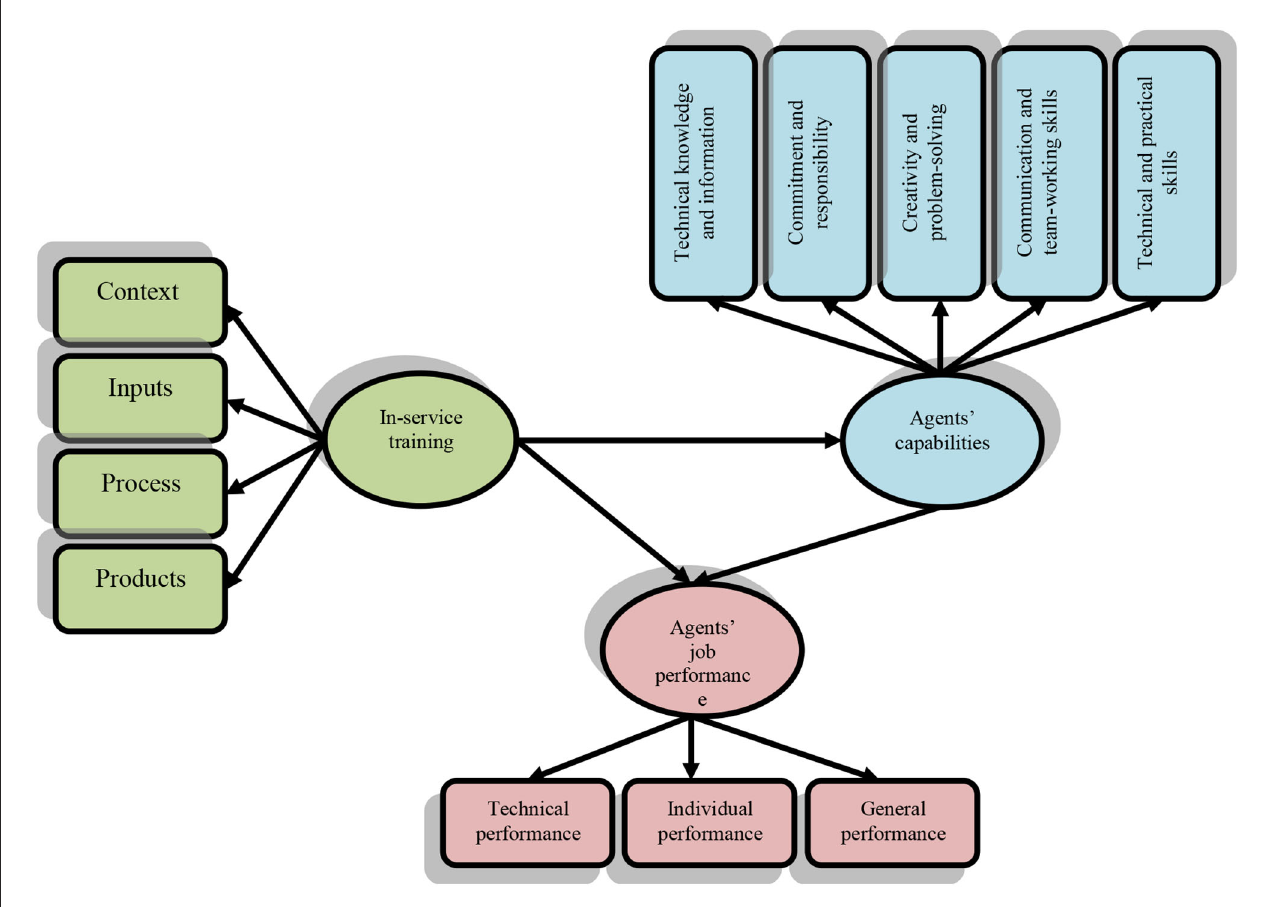
FIGURE1 The conceptual framework of the study.